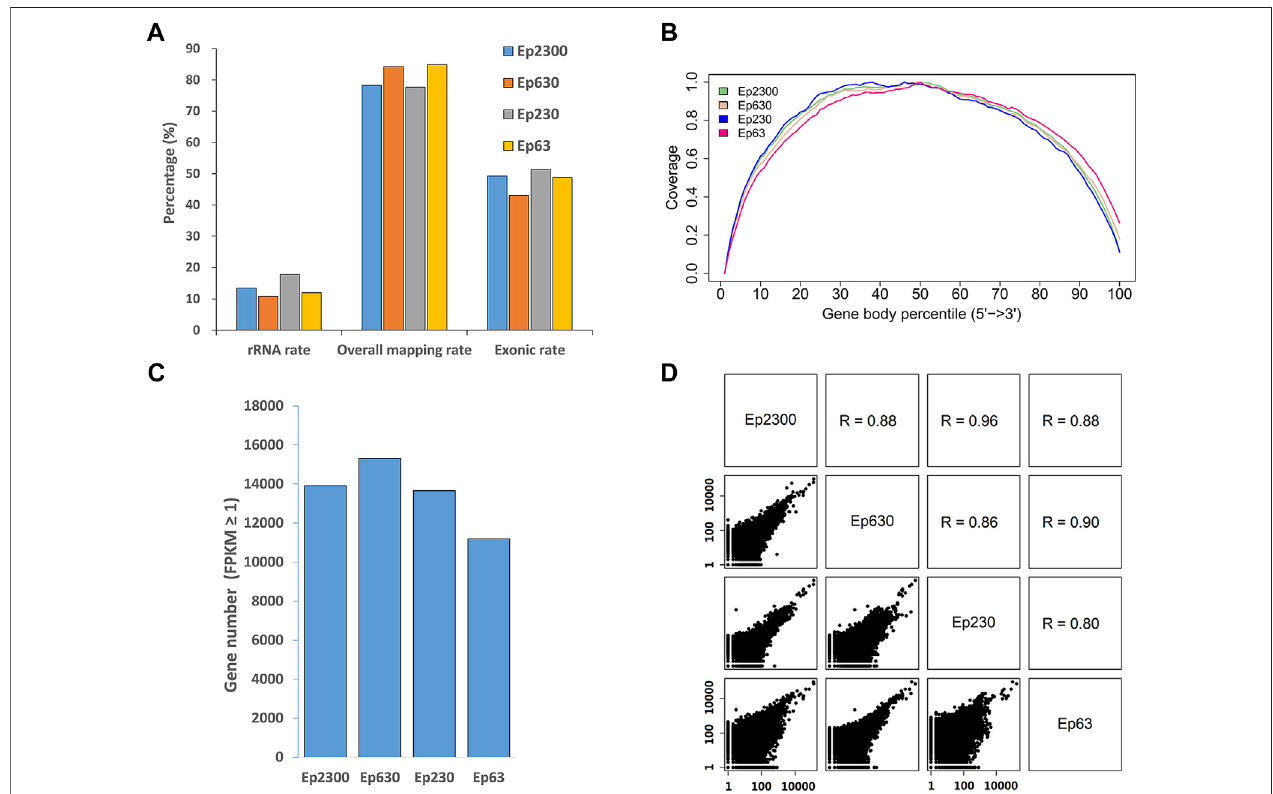
FIGURE6| AssessmentofthedataqualityandreproducibilitywithdifferentamountsofinputmaterialdissectedfromthemousesmallintestineusingPanCKasthe marker. The number of cells in each sample is indicated by the value following “ Ep ” , i.e., Ep63 = 63 cells. (A) Proportion of the overall mapping rate, the rRNA mapping rate and exonic rate of the samples. Despite a greater than 30-fold difference in the input material, the data quality remained consistent. (B) Reads distribution over the gene body isnormal, without5 ′ or 3 ′ end enrichment. (C) The number ofexpressed genesdetected inall ofthesamplesissimilar, but isalittlelower withthe Ep63 sample, suggesting that the RNA extraction step could be further optimized. (D) Pairwise scatter plots between all samples. These Pearson correlation coef fi cients indicate that these results are consistent with each other.